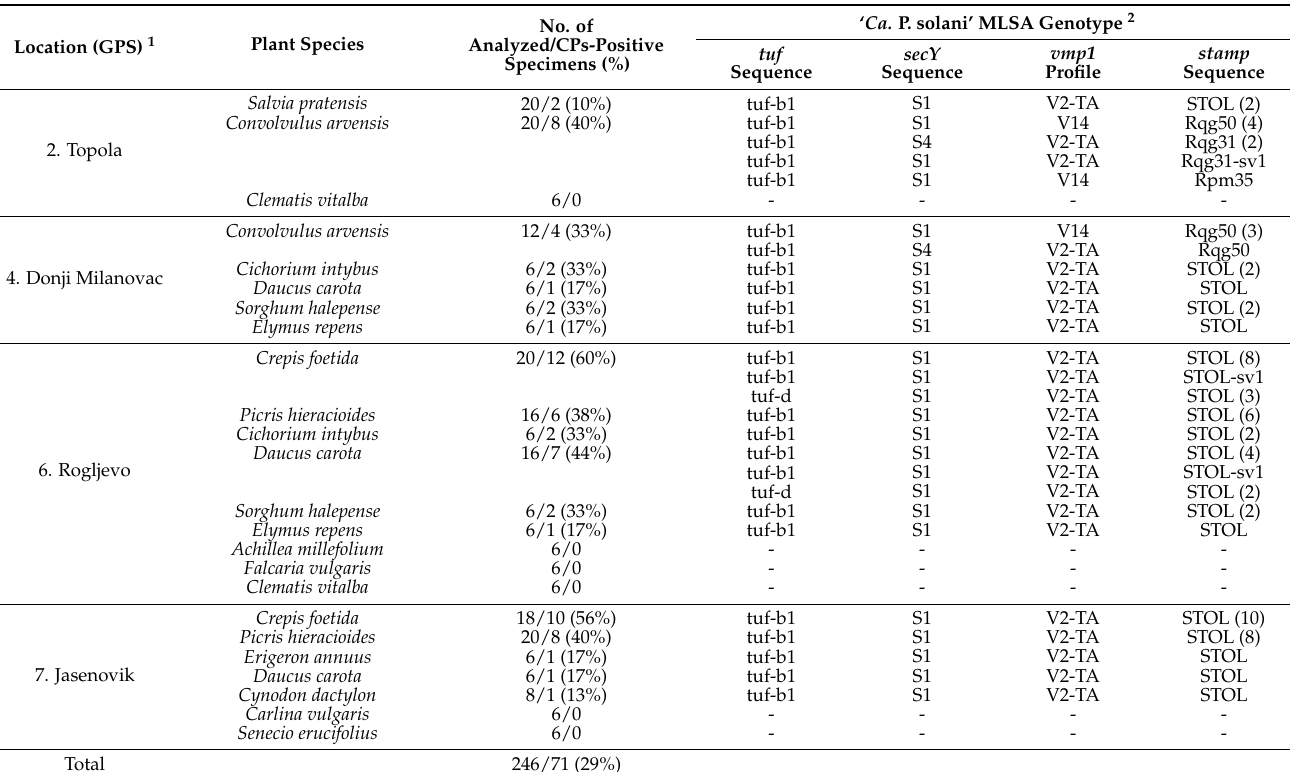
Table 2. ‘ Candidatus Phytoplasma solani’ identification in surveyed asymptomatic weeds (frequency and genotype) collected in September